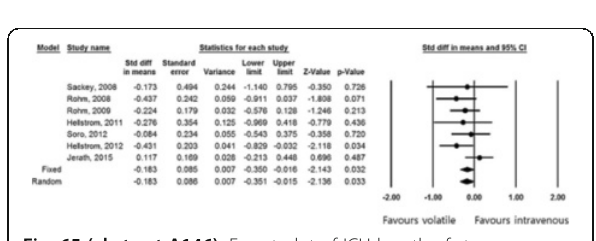
Fig. 65 (abstract A146). Forest plot of ICU length of